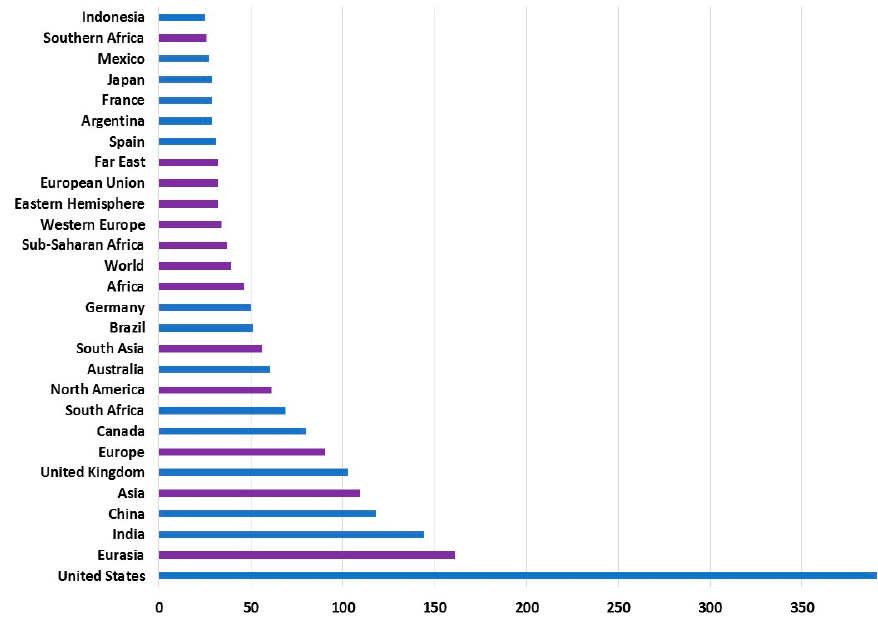
Figure 8. Worldwide keywords related to a geographical area.